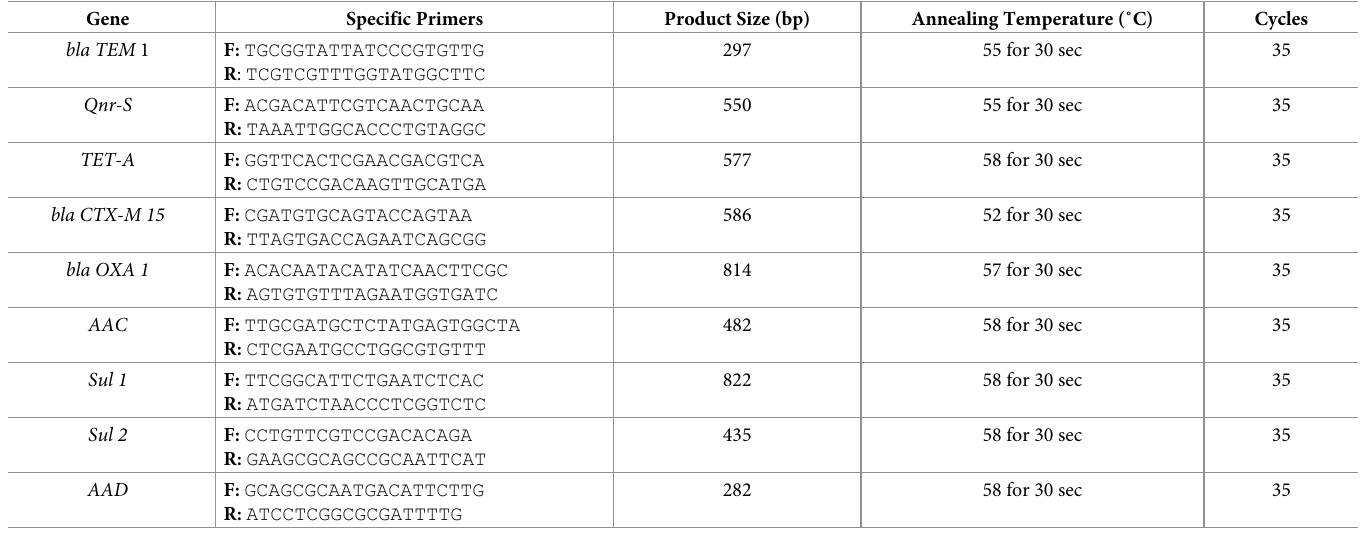
Table 3. Sequences of primers, along with optimized conditions, used in the current study [19].